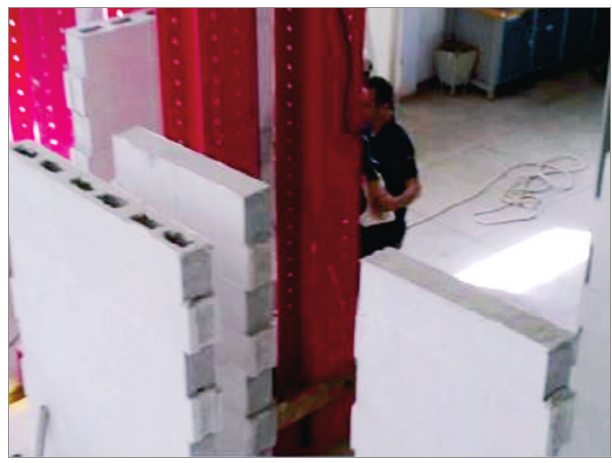
Figura 15 Ilustração do capeamento das paredes com